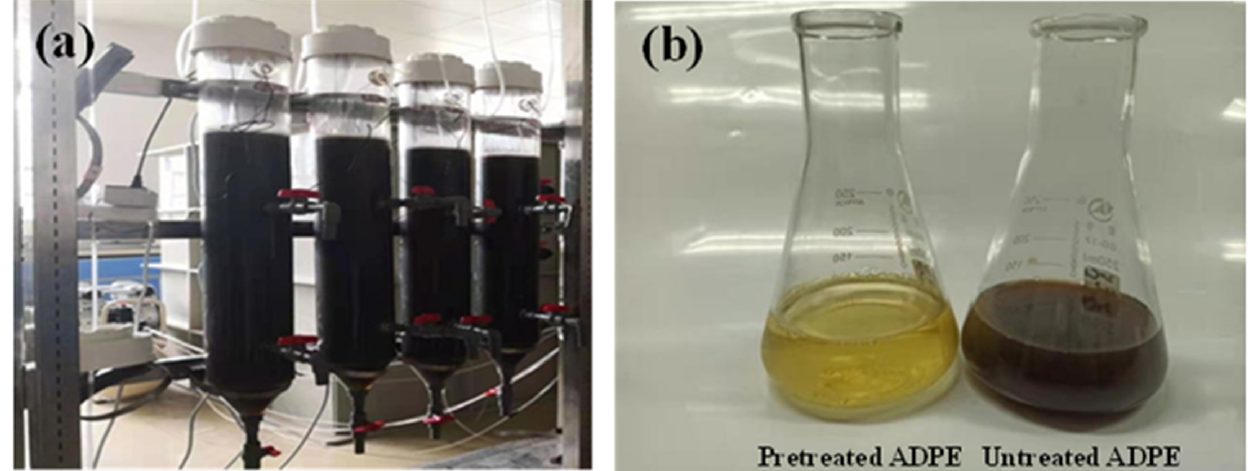
Figure 1. Homemade airlift bioreactor for the decolorization of anaerobic digestion piggery effluent (ADPE) through fungal pretreatment ( a ) and 10-fold (10×) diluted ADPE with and without fungal pretreatment ( b ).